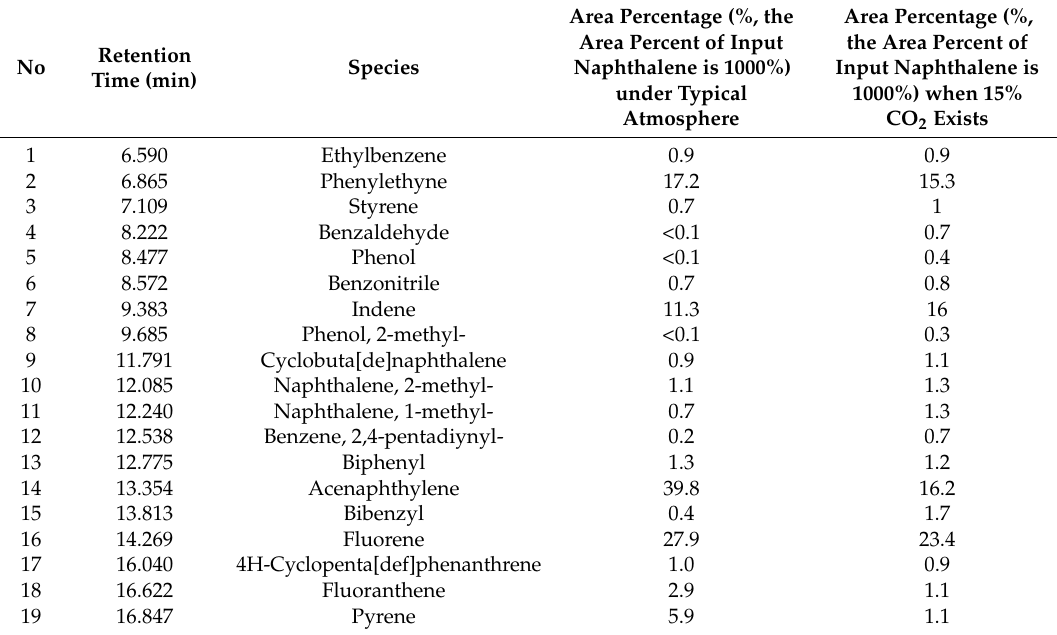
Table 1. Liquid by-products detected by GC/MS (in typical atmosphere with or without CO 2